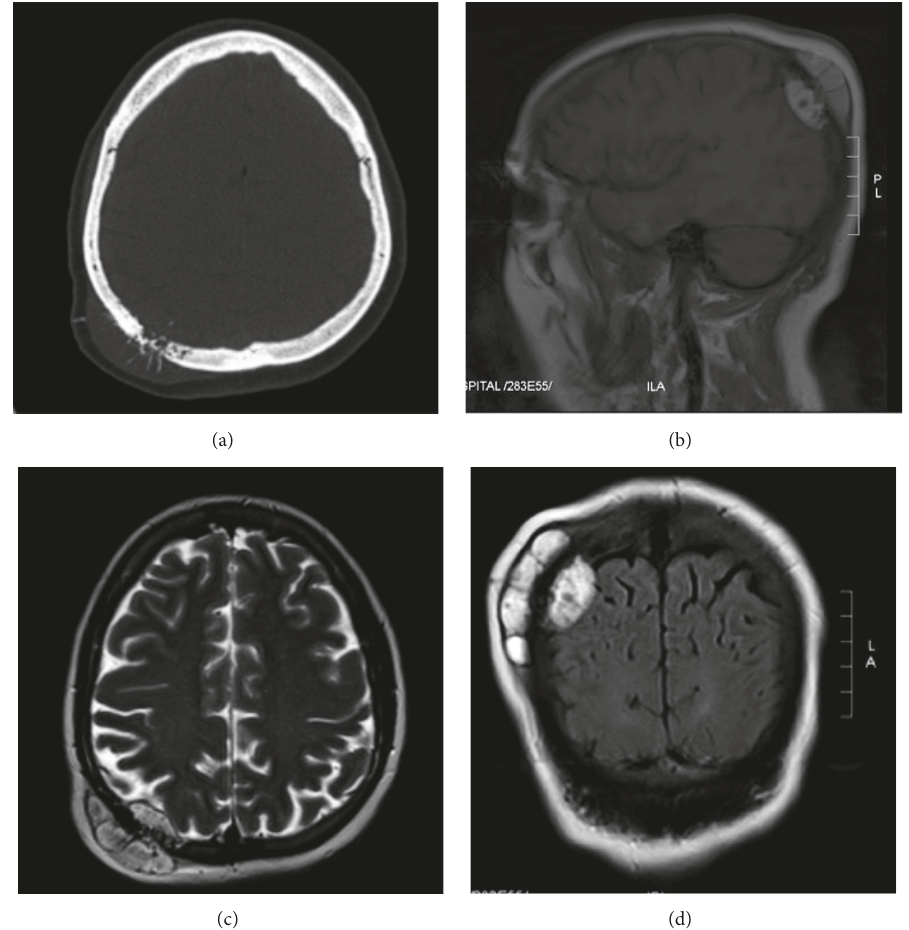
Figure 1: (a) Preoperative axial CT scan of the brain (bone window) showing osteolytic changes with associated soft tissue swelling. (b) Preoperative unenhanced parasagittal T1-weighted MRI image showing hyperintense epidural cystic mass compressing the cortex underlying. (c) Preoperative axial T2-weighted MRI image showing mildly hyperintense mass on the right parietal region. (d) Preoperative FLAIR coronal MRI showing hyperintense mass that traverses the skull.